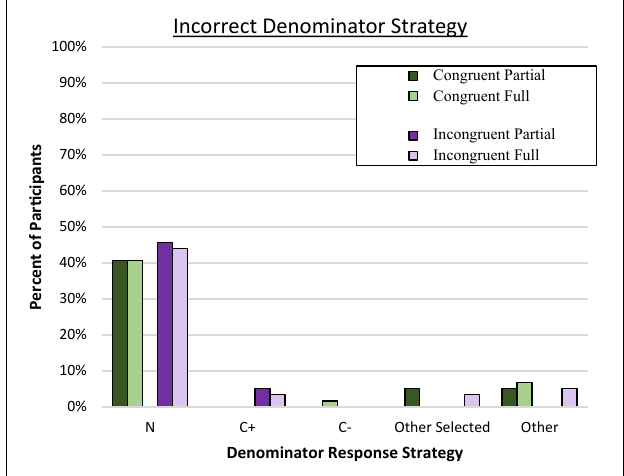
FIGURE 2 | Proportion of participants who consistently used the incorrect denominator strategy on frequency responses. C ± denotes the total number of people who have or do not have the condition. Total N denotes the total in the superordinate set (i.e., sample